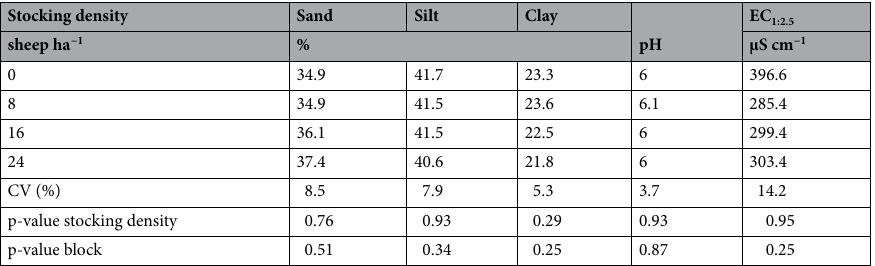
Table 1. Soil texture, pH and electric conductivity (EC) of a rangeland soil grazed by 0, 8, 16, and 24 sheep ha −1 in a two year grazing experiment from 2014–2015 on a summer pasture in the Chinese Altai Mountains, Qinghe, China. CV = mean coefficient of variation for grazing treatment.